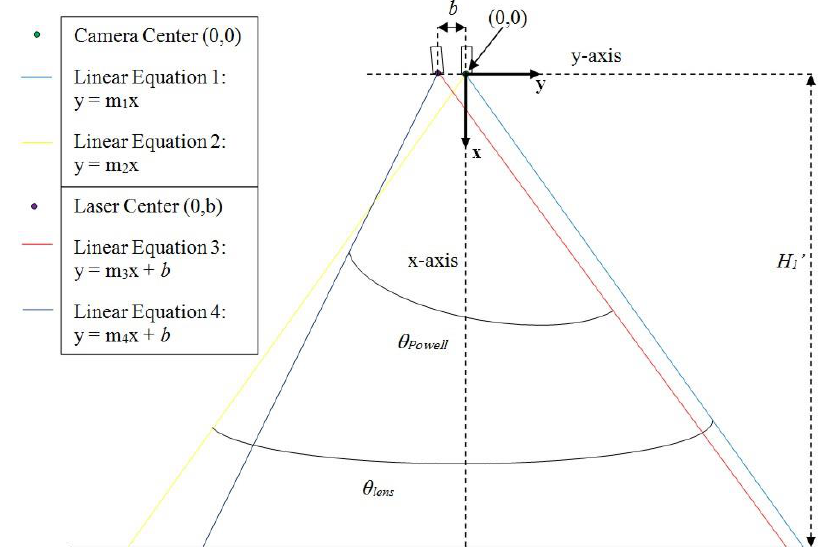
Figure 6. Imaging and illumination fields and equations when the camera lens’ center is assumed to be at the origin. The laser lens’ center is assumed to be along the y -axis and at an offset b from the center of the camera lens. Note m 1 = tan( θ lens /2), m 2 = tan( − θ lens /2), m 3 = tan( θ laser + θ Powell /2), and m 4 = tan( θ laser − θ Powell /2) with θ laser being the angle of the laser relative to the camera.